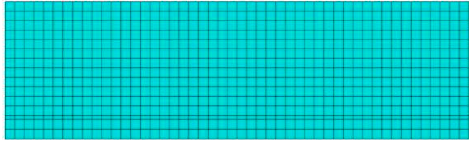
Figure 9. Meshes on Section 2-2.